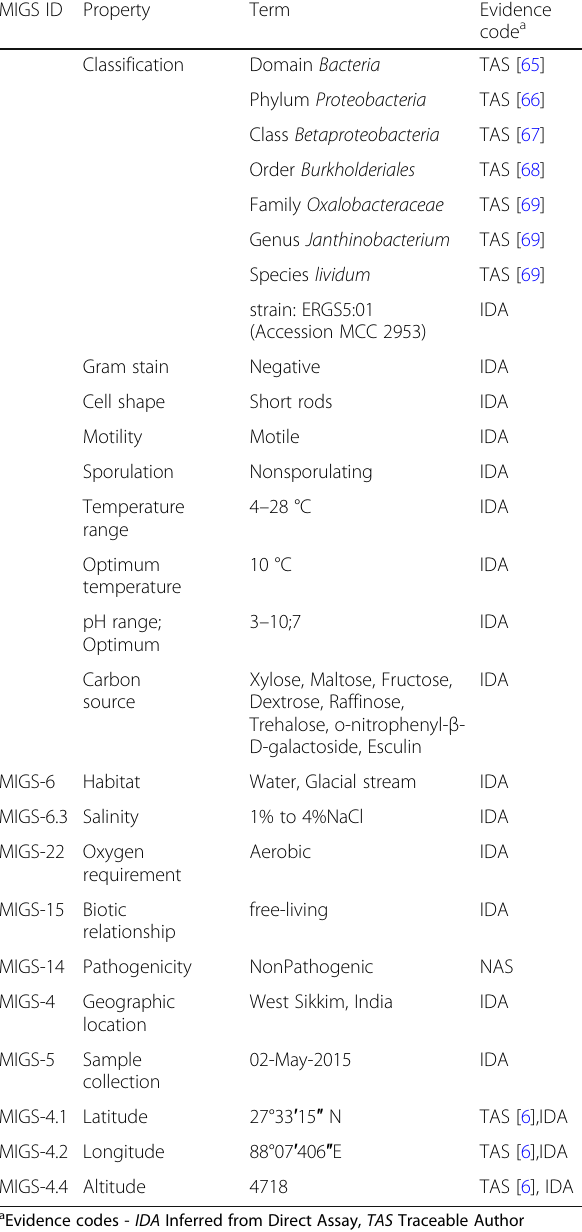
Table 1 Classification and general features of Janthinobacterium lividum ERGS5:01